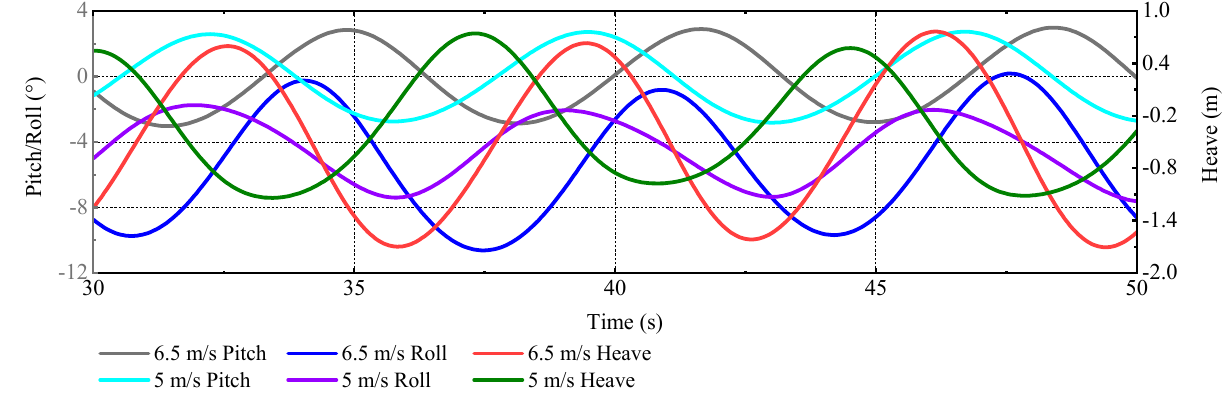
Figure 14. Time histories motion corresponding to different forward speeds ( θ = 45°).